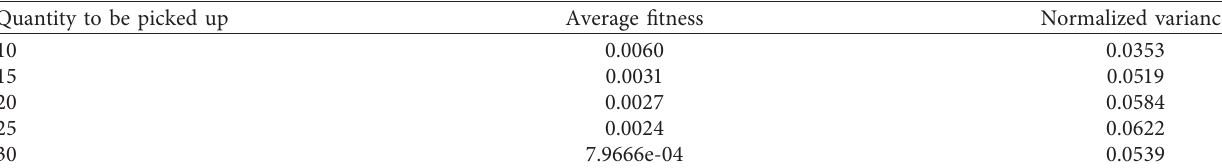
Table 3: Bicycle pickup.